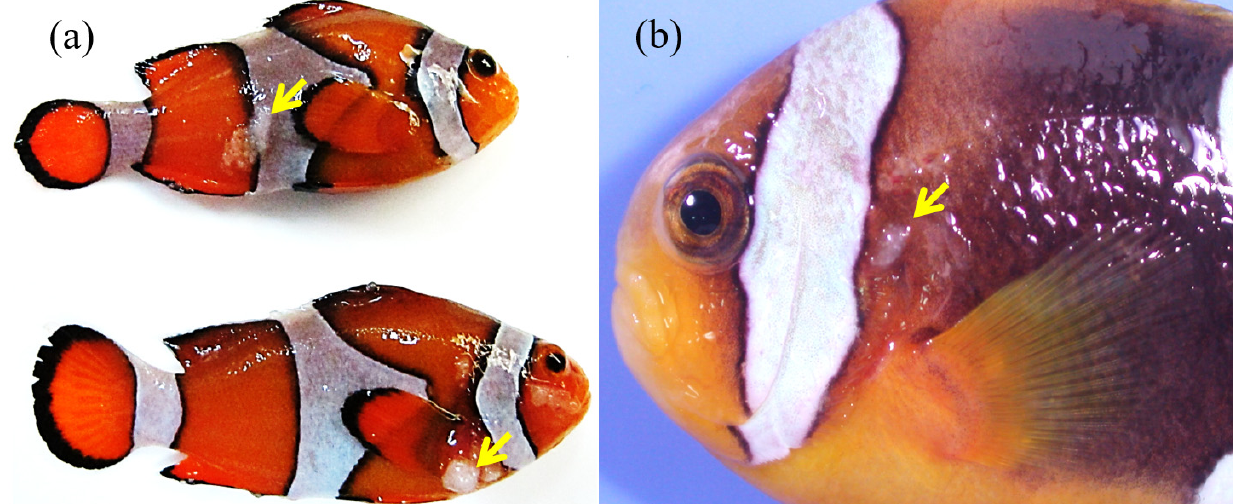
Figure 1. Macroscopic view of Lymphocystis disease virus (LCDV) infected Amphiprion ocellaris ( a ) and A. clarkii ( b ). Yellow arrows are white nodules.